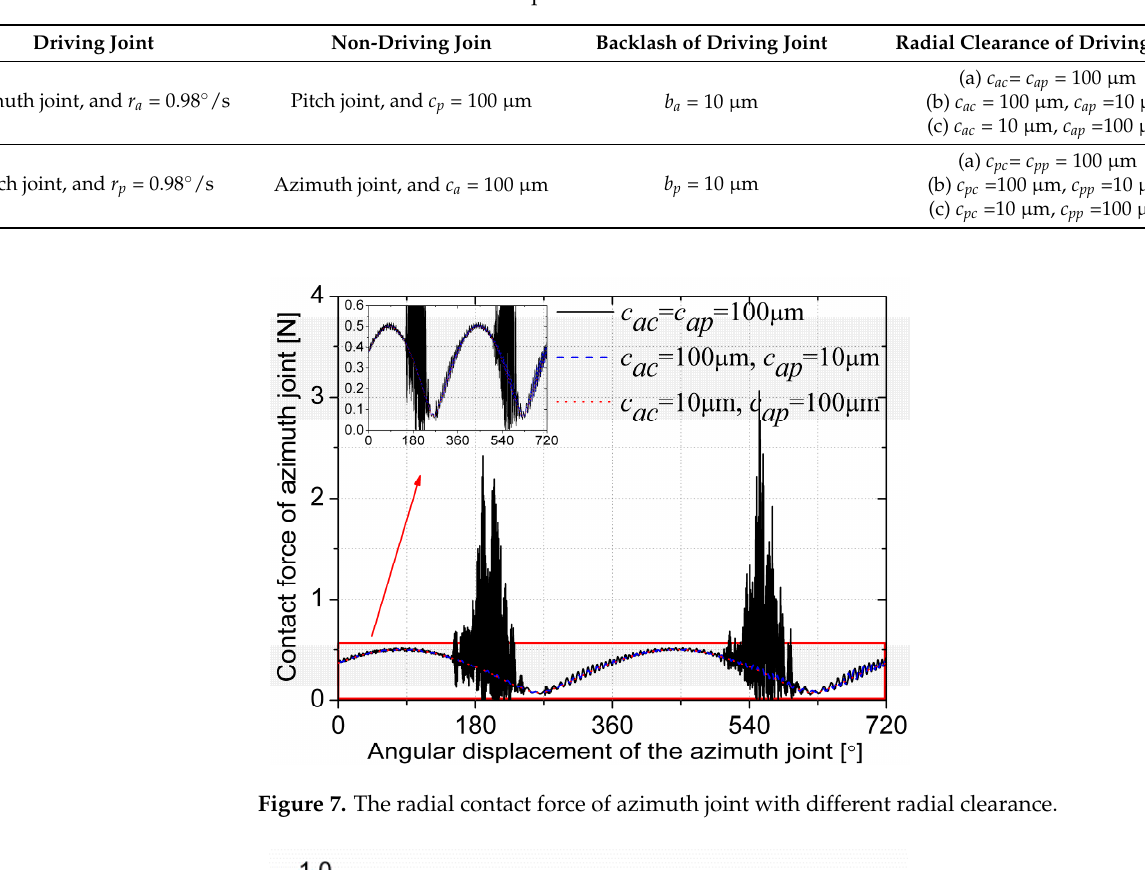
( b ) Figure 6. Radial contact force with a different rotational speed of pitch joint—( a ) radial contact force of azimuth joint output side and ( b ) radial contact force of pitch joint output side. 3.1.2. Effects of Radial Clearance To investigate the effects of the coupling between the radial clearances inside the joint in the dual-axis driving mechanism on the system dynamic characteristics, the parameters of each part used in the simulation are shown in Table 3. When the azimuth joint and the pitch joint are respectively used as the driving joint. The change curves of the radial con-